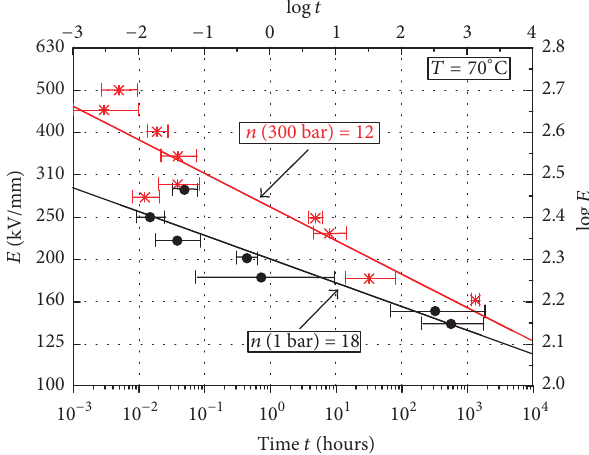
Figure 2: Weibull plot of the electrical ageing data of XLPE at 220 kV/mm and 70 ∘ C.